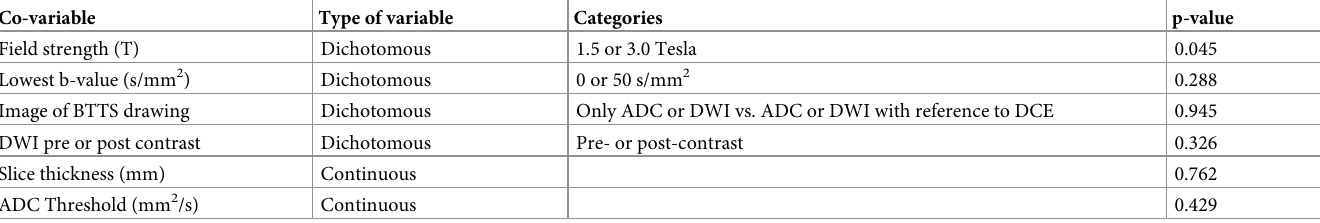
Table 3. Meta-regression analysis of pooled data of all 65 study subsets using a random effect